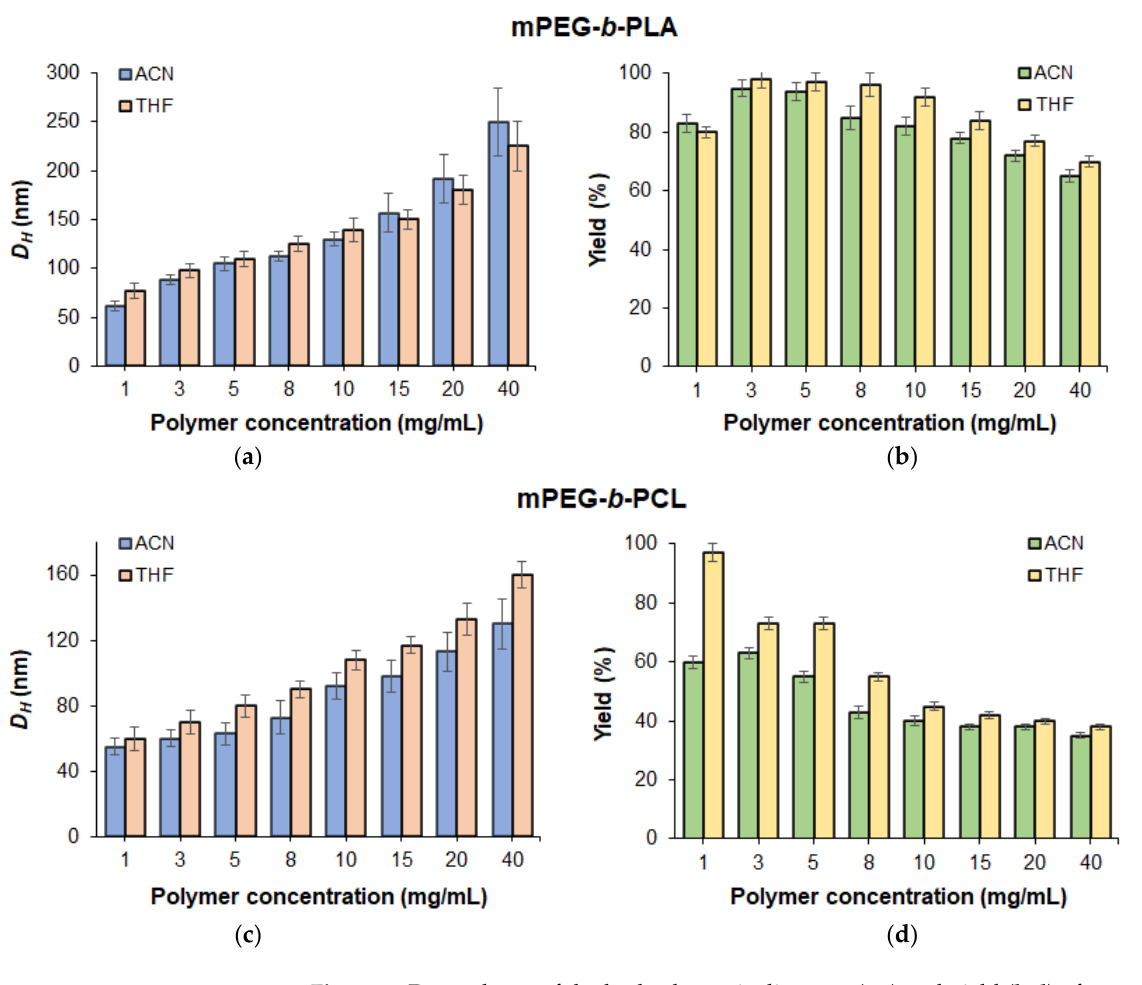
Figure 3. Dependence of the hydrodynamic diameter ( a , c ) and yield ( b , d ) of nanoparticles on the concentration of mPEG- b -PLA ( a , b ) and mPEG- b -PCL ( c , d ) (mixing rate: 850 rpm; aqueous phase: deionized water). Table 2. Characteristics of the polymer nanoparticles obtained under optimized